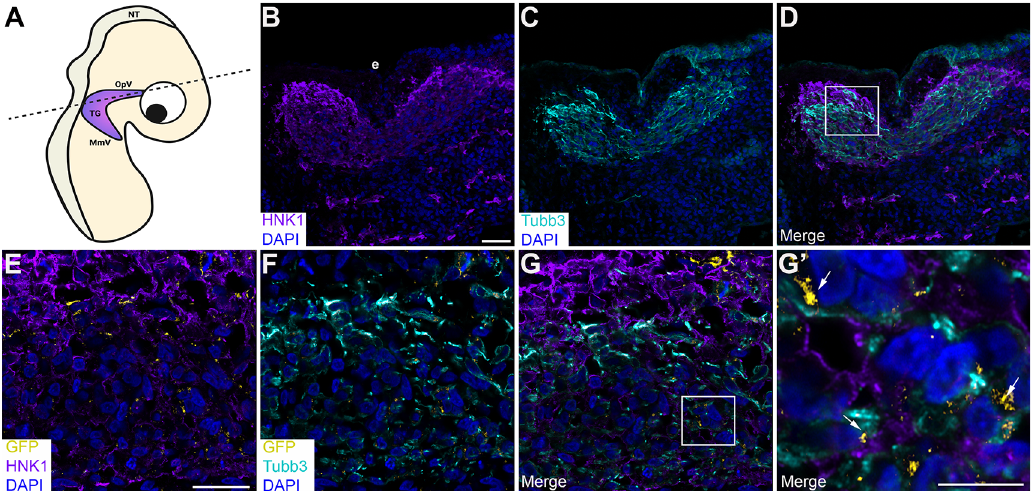
Figure 7. Cadherin-7 GFP1-10 and N-cadherin GFP11 form heterophilic interactions in trans in the trigeminal ganglion. (A) Cartoon diagram of a chick embryo showing the forming trigeminal ganglion, with the dotted line indicating the axial level at which images were captured. Diagram created with BioRender.com. Sequential electro- porations in the chick embryo were conducted as follows: Premigratory neural crest cells were first electroporated with Cad7 GFP1-10 followed by electroporation of trigeminal placode cells with N-cad GFP11. Section immunohisto- chemistryforHNK1(purple,marksneuralcrestcells;B,D,E,G,G ’ )andTubb3(cyan,marksneuronswhichareplacode cell-derived at this stage; C, D, F, G, G ’ ) was then performed. GFP signal (yellow, arrows, E-G ’ ) was captured in the appropriate channel(488). (B-D) Representative sections that show themorphology of thetrigeminalganglion at this stage of development. (E-G) Higher magnification images of the boxed region in (D). (G ’ ) Higher magnification image oftheboxedregionin(G),withGFPidentifiedbyarrows.DAPI(blue),cellnuclei.Scalebarin(B)is100 μ mandappliesto (C-D); scale bar in (E) is 100 μ m and applies to (F-G); and scale barin (G ’ ) is 50 μ m. N=6 embryos. NT,neural tube; MmV, maxillomandibular lobe; OpV, ophthalmic lobe; TG, trigeminal ganglion; e, ectoderm; N-cad, neural cadherin; Cad7,